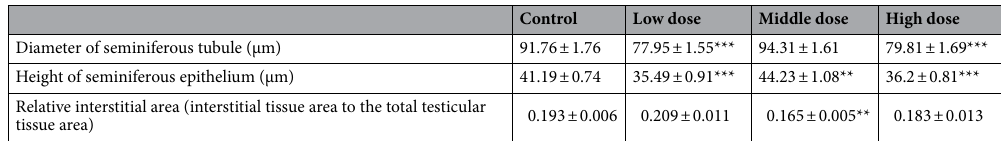
Table 3. Testicular morphology of CORT-administered mice on PND 10. Values are expressed as the mean ± S.E.M. of data from 10 animals per group (10 seminiferous tubules or pictures per animal). **p < 0.01, and ***p < 0.001 versus the control group. CORT